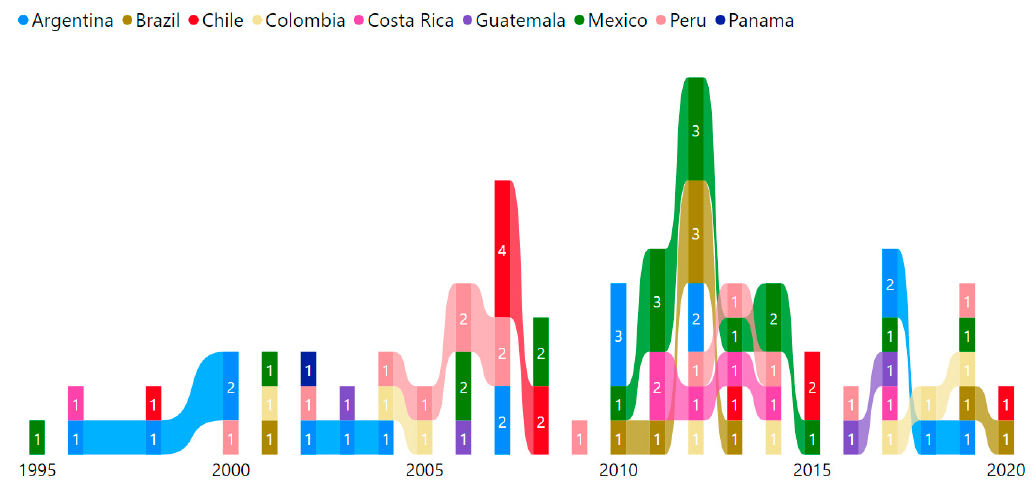
Figure 5. Chronology of the green building rules launched. Each number indicates the GBRs promulgated in a given country (coded by colour) in a given year.